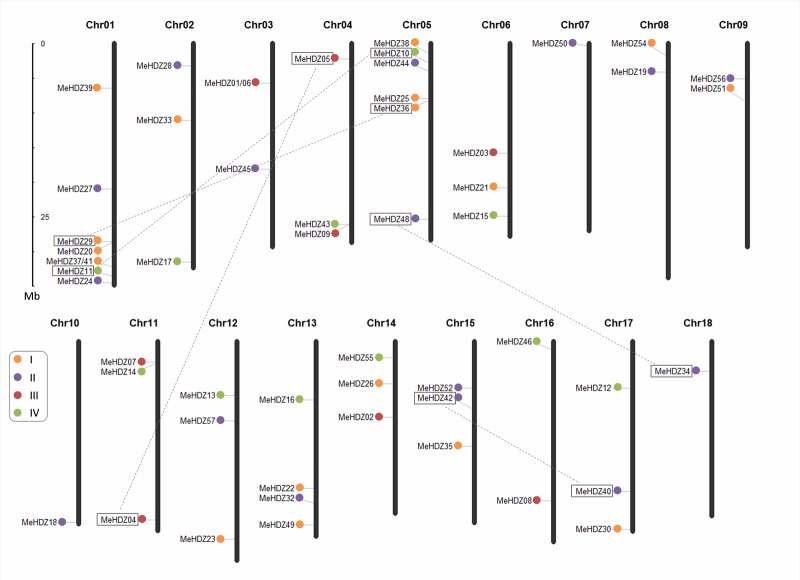
Physical locations of MeHDZ genes on cassava chromosomes.Chromosome numbers were indicated at the top of each chromosome. MeHDZ genes from different subfamilies were indicated by different colors. Five pairs of MeHDZ genes connected by dash lines were resulted from segmental duplication.